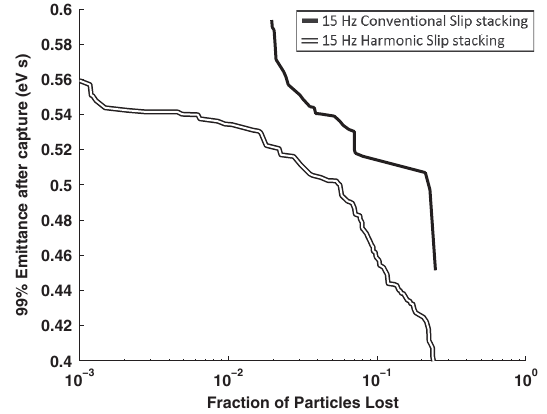
FIG. 18. Pareto fronts for particle loss rate and emittance after